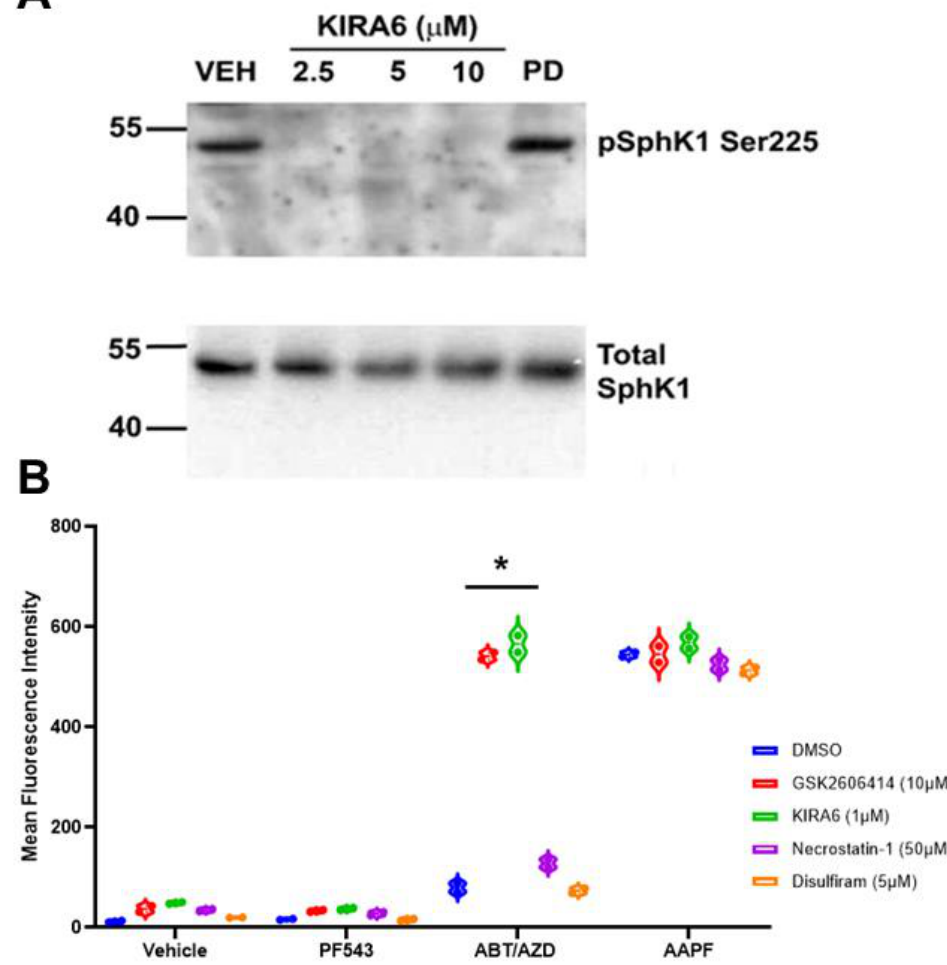
Figure 6. Inhibition of IRE1 α blocks activating phosphorylation of SphK1 at Ser225 in a HEK293 over-expression system. ( A ). HEK293 cell over-expressing FLAG-SphK1 [15] were treated with the IRE1 α kinase domain inhibitor KIRA6 at the indicated concentrations. Phosphorylation of SphK1 at Ser225 was determined using phospho-specific S225 antibodies (ECM Bio). IRE1 α inhibition com- pletely blocked SphK1 phosphorylation as low as 2.5 µ M. Erk1/2 has been previously demonstrated to mediate SphK1 phosphorylation at Ser225 [32], however, PD-98059 (20 µ M) had no effect on phos- phorylation of SphK1. ( B ). Inhibition of IRE1 α (KIRA) and PERK (GSK2606414), two arms of the UPR, enhanced cell surface exposure of ectoCRT. Statistical analysis was performed using one-way ANOVA followed by Tukey’s multiple comparison test. (* p ≤ 0.05) Asterisks indicate significant changes as reported in results section. Pyroptosis (Disulfiram) and necroptosis (Necrostatin-1) inhibitors had no effect on exposure of ectoCRT indicating ICD is distinct from these forms of RCD. The uncropped blots are shown in Figure